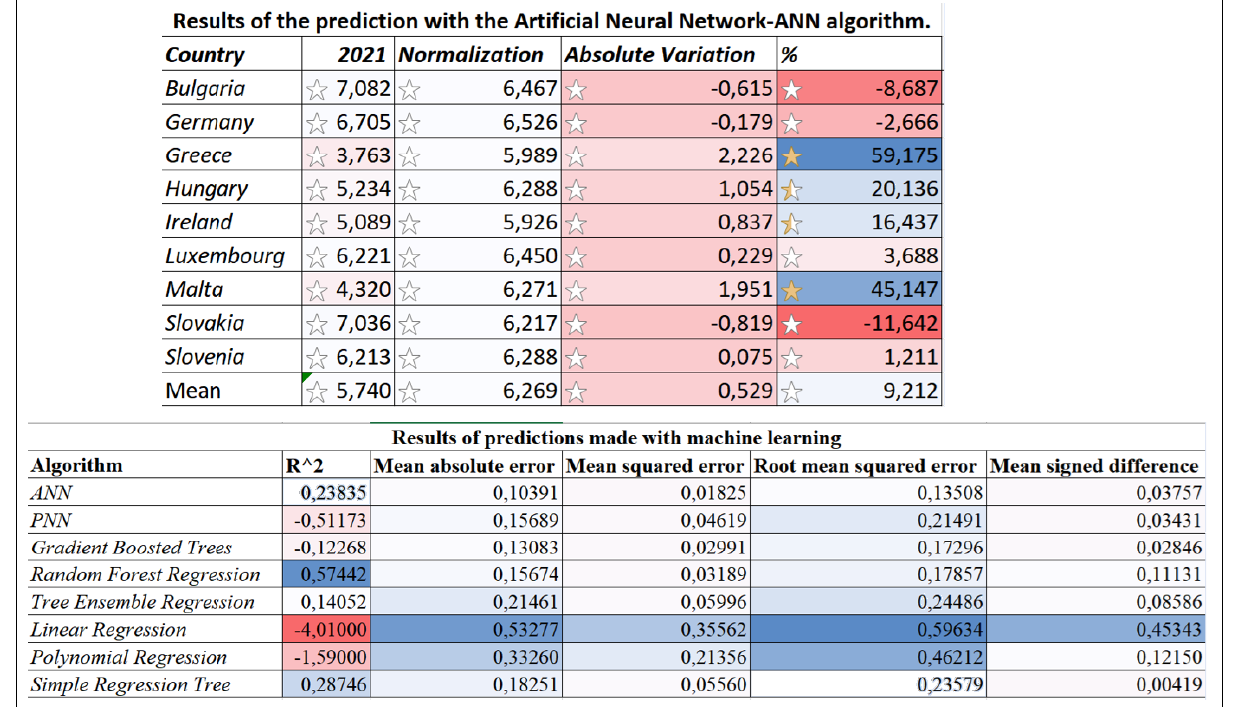
Figure 4. Results of machine learning algorithms for